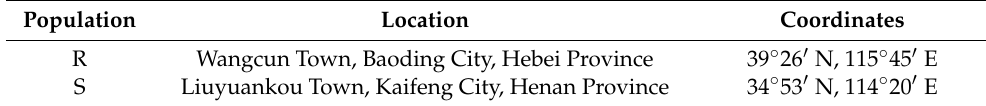
Table 3. Geographical locations of the collection sites for the seeds of resistant B. japonicus . Population Location